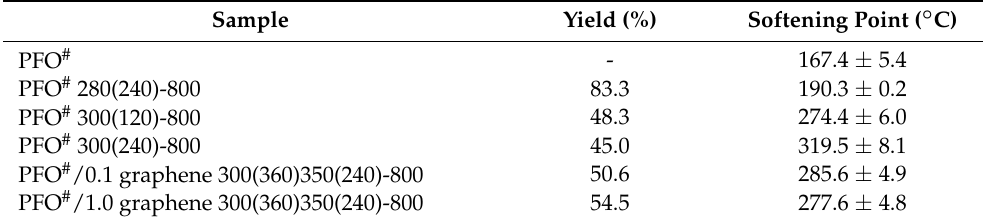
Table 1. Yields and Softening Points of Pitches Synthesized as Functions of Thermal Treatment Conditions and Graphene Addition.